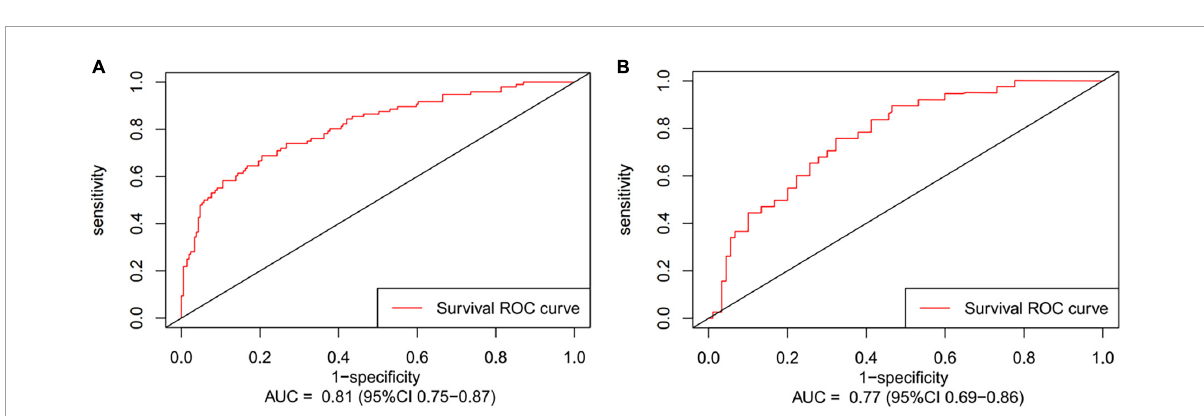
FIGURE3 The receiver operating characteristic curves (ROC) of post-operative 12 months follow-up present area under the curve (AUC) in development cohort (A) and validation cohort (B)